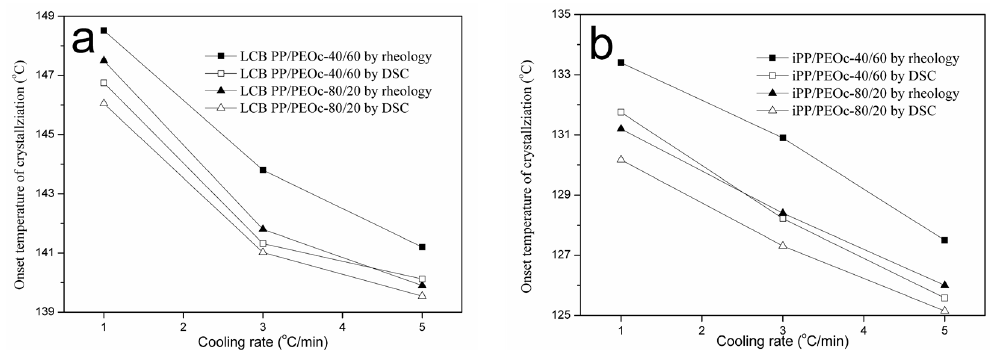
Figure 10. Plot showing the onset temperature of crystallization for ( a ) LCB PP/PEOc blends and ( b ) iPP/PEOc blends as a function of cooling rate, as determined from the rheological and DSC experiments.